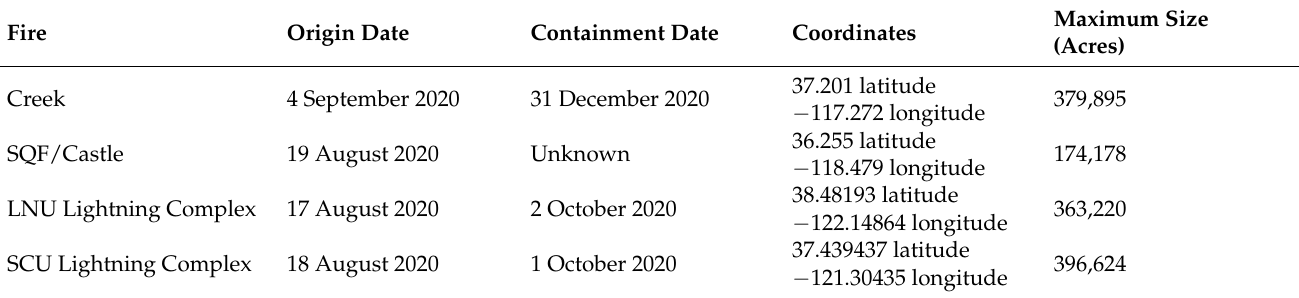
Table 1. Origin date, containment date, coordinates and size for fires considered in this study [40– 43].